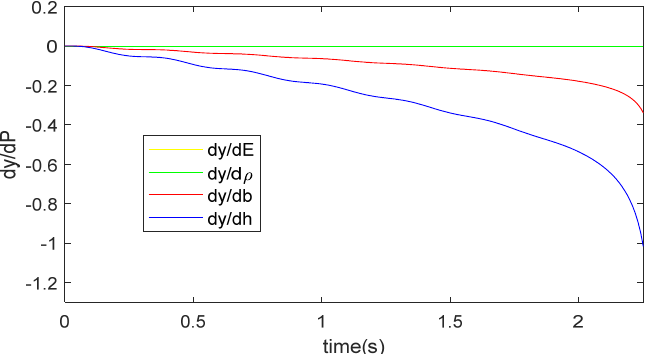
Figure 13. The sensitivity of the solution y with respect to the design parameters E , ρ , b and h .